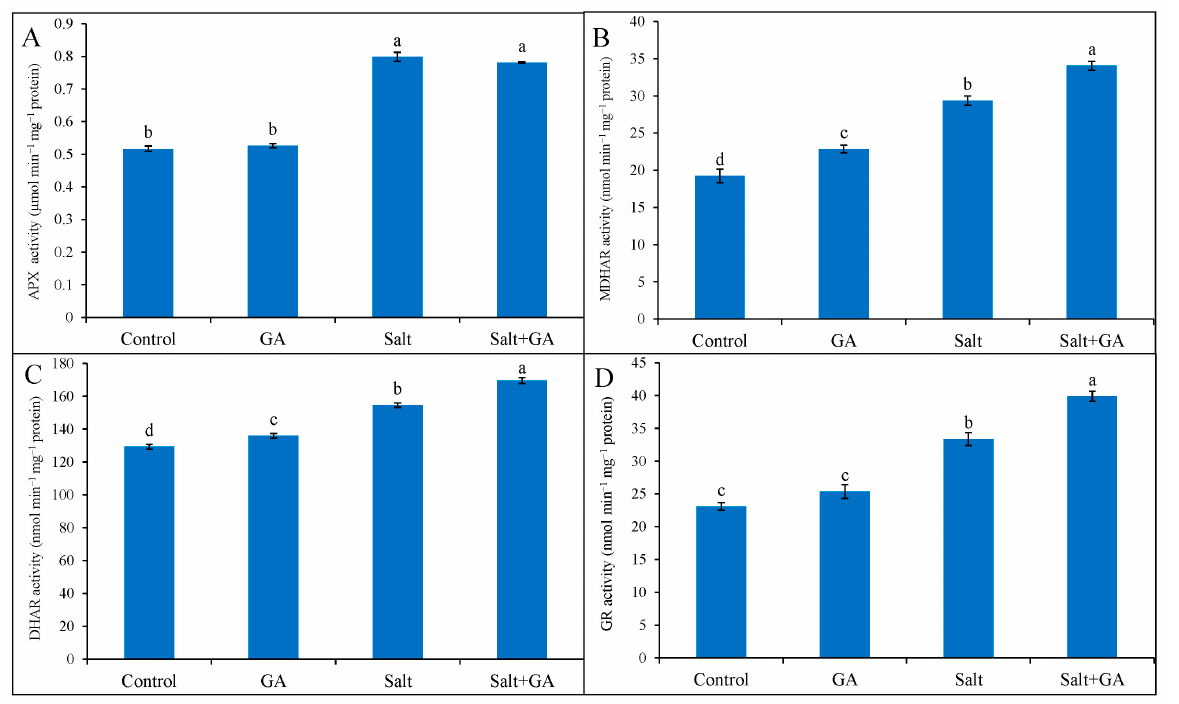
10 of 16 Figure 5. Phenolic compounds (total phenol, ( A ) and flavonoid contents, ( B )) of salt-treated rice ( O. sativa L. cv. BRRI dhan52) seedlings as influenced by GA supplementation. 1 mM gallic acid and 200 mM NaCl are specified by GA and salt, correspondingly. Values with different letters are sig- nificantly different at P ≤ 0.05 applying the Tukey’s HSD test. 3.8. Effect on Antioxidant Enzymes External application of GA on control rice seedlings did not influence antioxidant